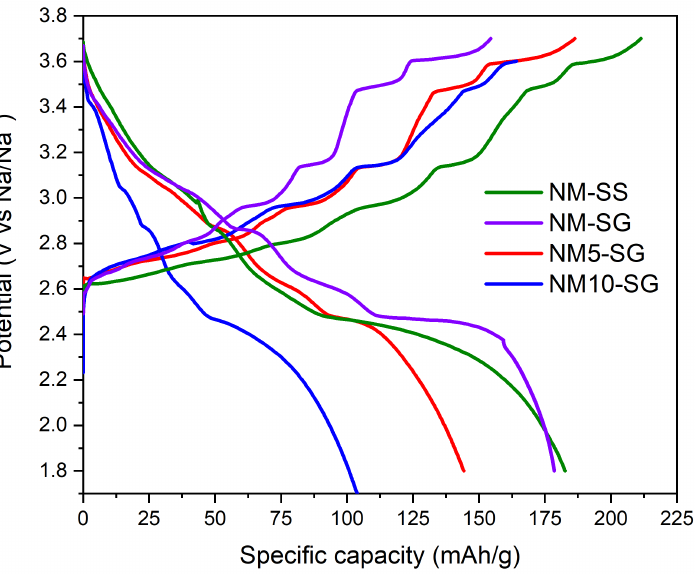
Figure 5. Voltage profile of the four materials during the first charge/discharge cycle.